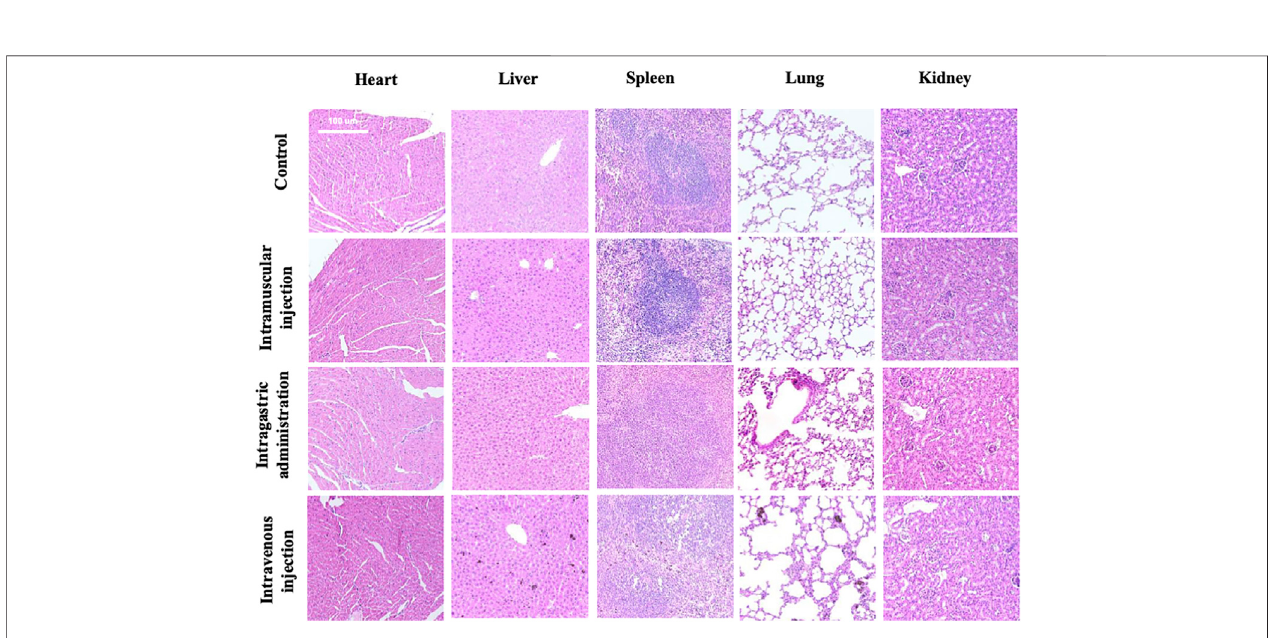
(NEB, United States), and each sample was labeled with an index code at the beginning.